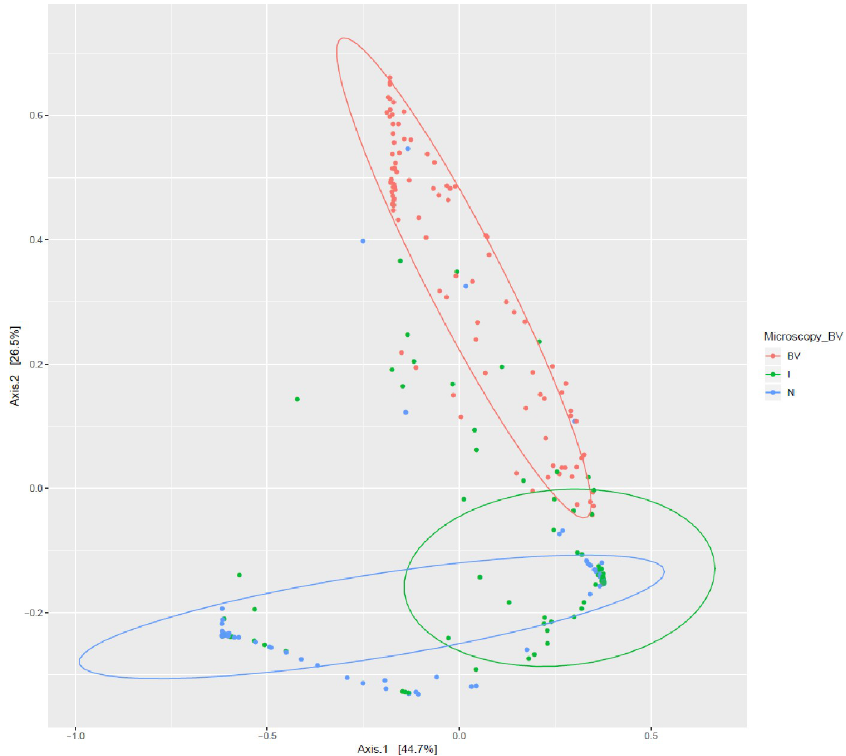
Fig 5. PCoA plot the 277 patient samples with a Nugent score. Clustering based on Bray Curtis dissimilarity calculated from taxonomic composition and colored according to Nugent score: Green = normal (Nugent 0–3), blue = intermediate (Nugent 4–6) and red = BV (Nugent score 7–10).